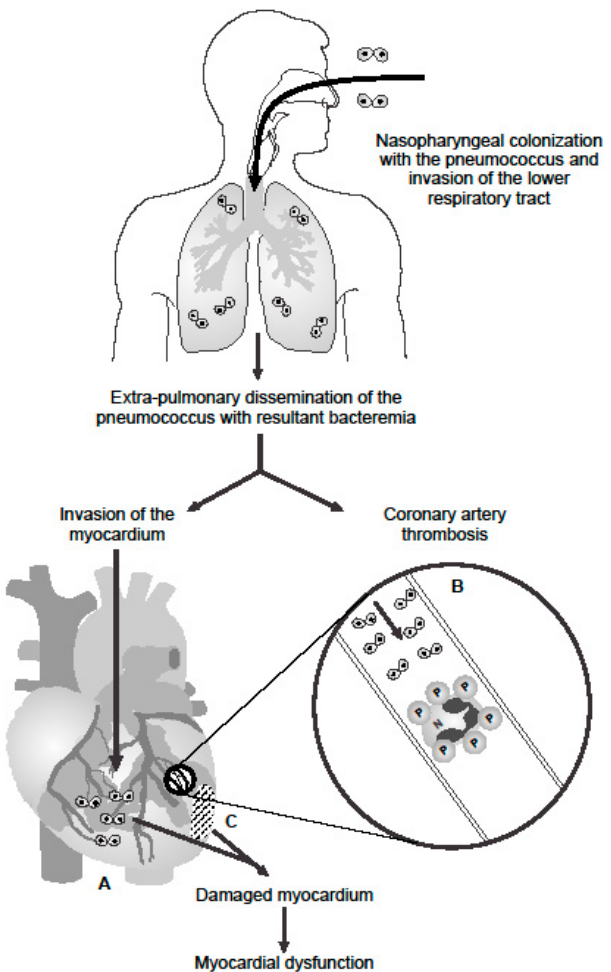
Figure 1. Proposed mechanisms involved in the pathogenesis of pneumolysin-mediated myocardial injury during invasive pneumococcal disease in humans. Following nasopharyngeal colonization, invasion of the lower respiratory tract, extra-pulmonary dissemination, and cardiac invasion by the pneumococcus ( ⨀⨀–symbol represents diplococci) , intra-myocardial and intravascular release of pneumolysin (PLY) by the pathogen results in A: PLY-mediated death and dysfunction of cardiomyocytes; B: intravascular activation of platelets and neutrophils with resultant formation of pro-thrombotic/pro-NETotic neutrophil (N):platelet (P) aggregates (as illustrated in the magnification of an affected coronary arteriole/artery); and C: development of myocardial damage and dysfunction.